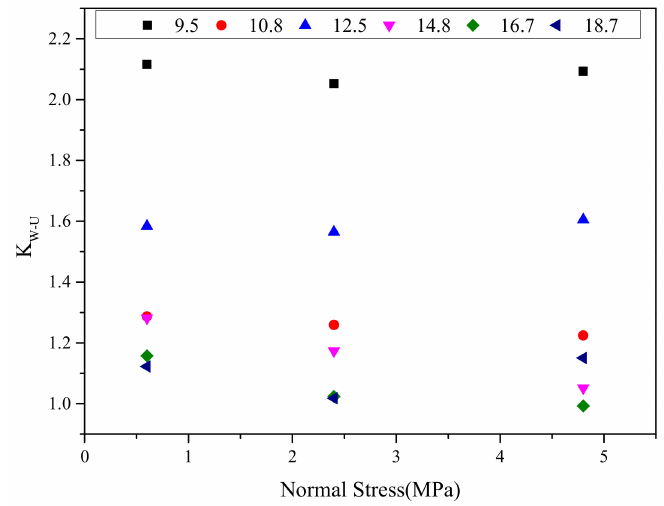
Figure 15. Mechanical contribution ratio of waviness and unevenness.